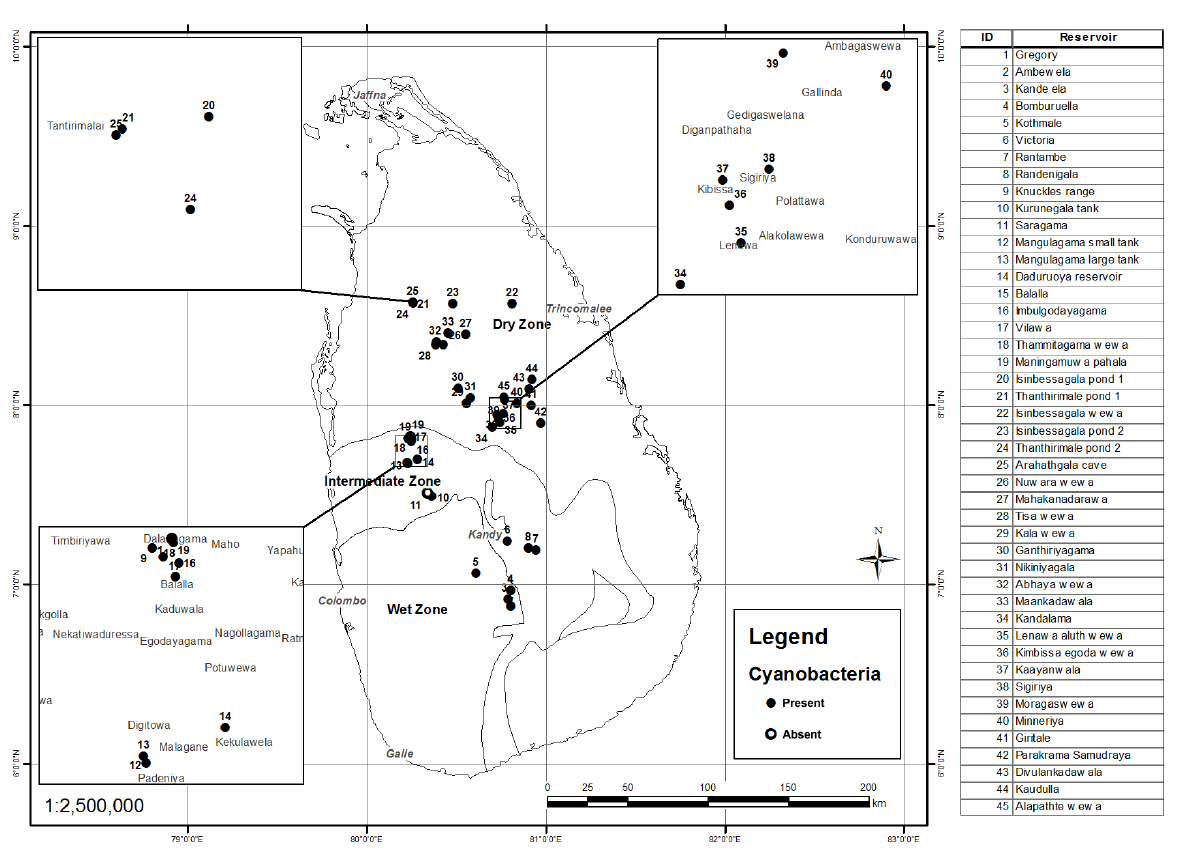
Figure 1: Locations of the 45 study reservoirs in Sri Lanka. The country is divided into three main climatic regions: the Dry Zone, the Intermediate Zone and Wet